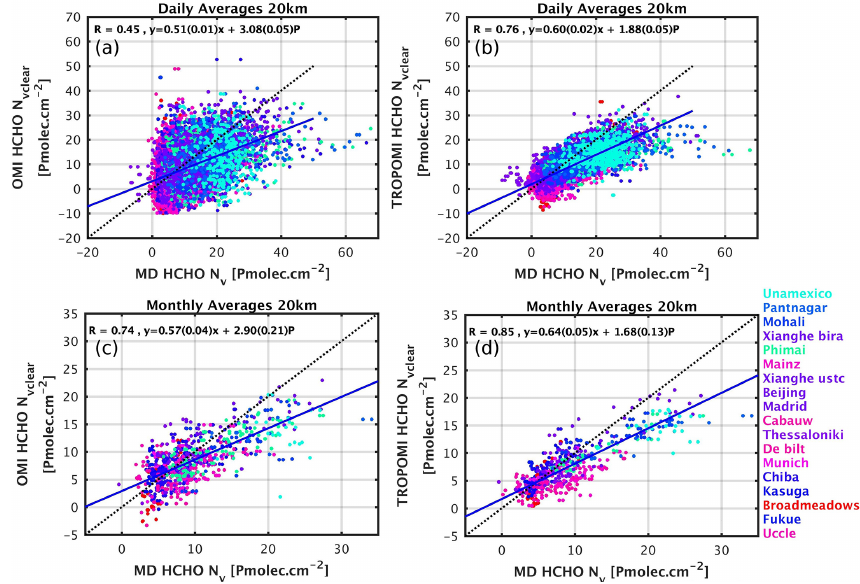
Figure 15. Scatter plots of OMI (a, c) and TROPOMI (b, d) versus MAX-DOAS data for the daily (a, b) and monthly (c, d) medians of col- located data. The correlation, slope and intercept of a linear regression using the robust Theil–Sen estimator is given in each panel and plotted as a blue line. The black dotted line is the 1:1 line. The colour indicates the latitude of the station. (Pmolec.cm − 2 = 10 15 molec.cm − 2 .) Table 3. Summary of validation results for OMI and TROPOMI when considering all collocated pairs (daily or monthly means) together. Values for HCHO columns lower or larger than 8 × 10 15 molec.cm − 2 are given in